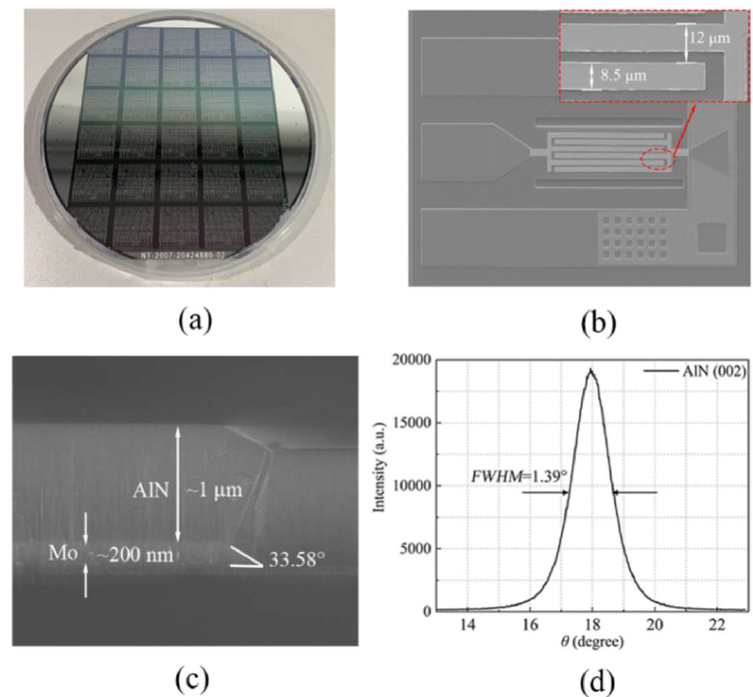
Figure 5. ( a ) The fabricated 6-inch wafer; ( b ) The fabricated AlN LWRs with the extended boundary of 12 μm; ( c ) SEM images of the cross section of the Mo sidewall; ( d ) XRD rocking curve of the 1- μm-thick AlN (002) layer.